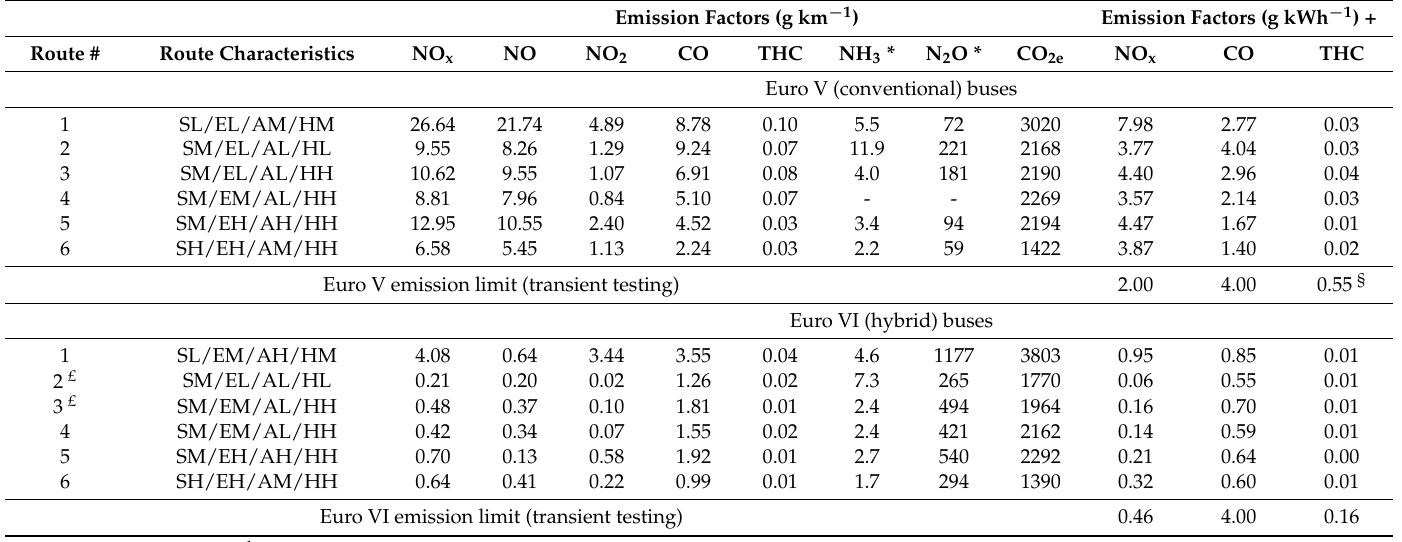
Table 4. Emission levels of basic pollutants per tested bus and